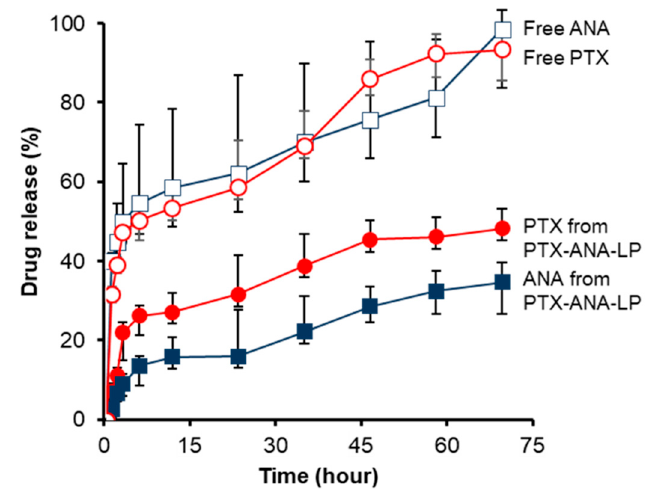
Figure 3. Release profiles of free PTX, free ANA, and PTX and ANA from PTX-ANA-LP at 37 °C in phosphate buffered saline (PBS, pH = 7.4; n = 3, mean ± standard deviation).